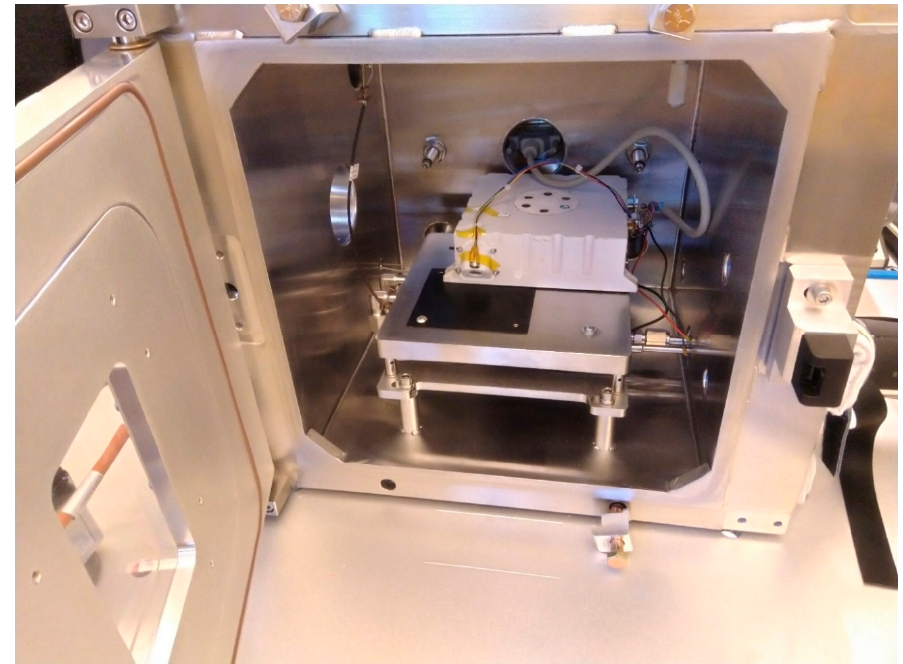
Figure 7. Configuration for the HabitAbility: Brines, Irradiation and Temperature (HABIT) ground temperature sensor (GTS) calibration inside SpaceQ chamber. The thermopile points to a small-sized thermographic paint-coated aluminum plate that serves as blackbody target, which is used as a reference for the calibration.